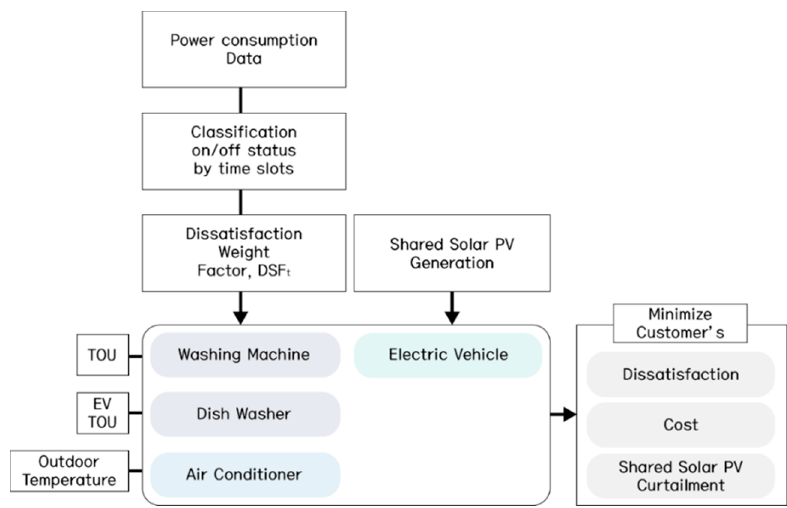
Figure 2. Flowchart for the proposed HEMS model process.